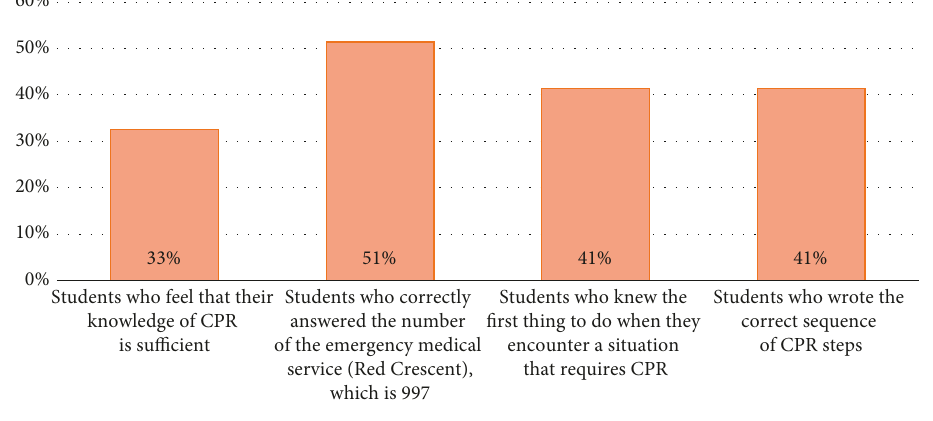
Figure 3: Students who have knowledge about cardiopulmonary resuscitation. Table 4: Students’ resources of CPR knowledge. Table 5: The attitude of the participants towards CPR.